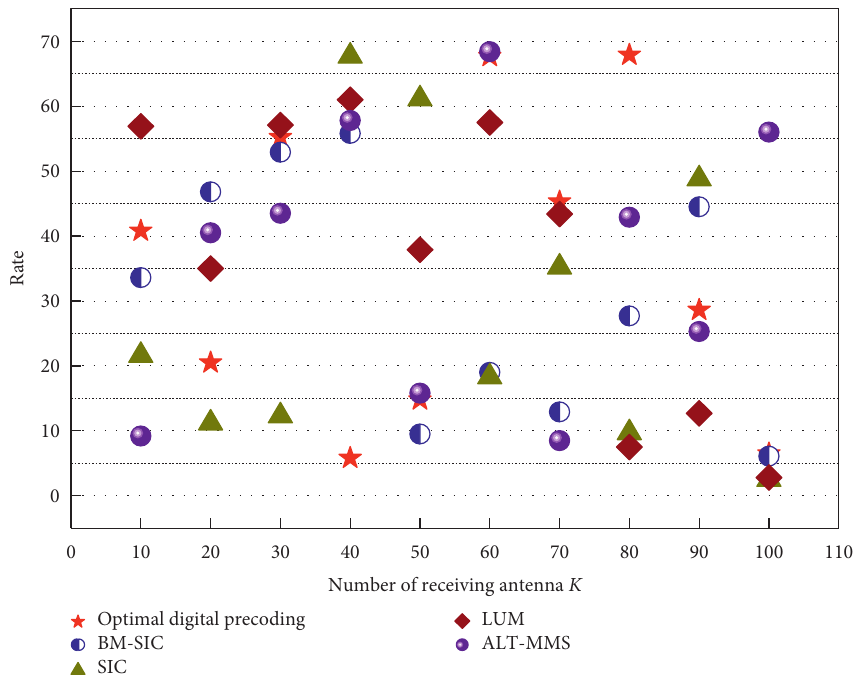
Figure 5: System reaches and rate vs. the number of receiving antennas.